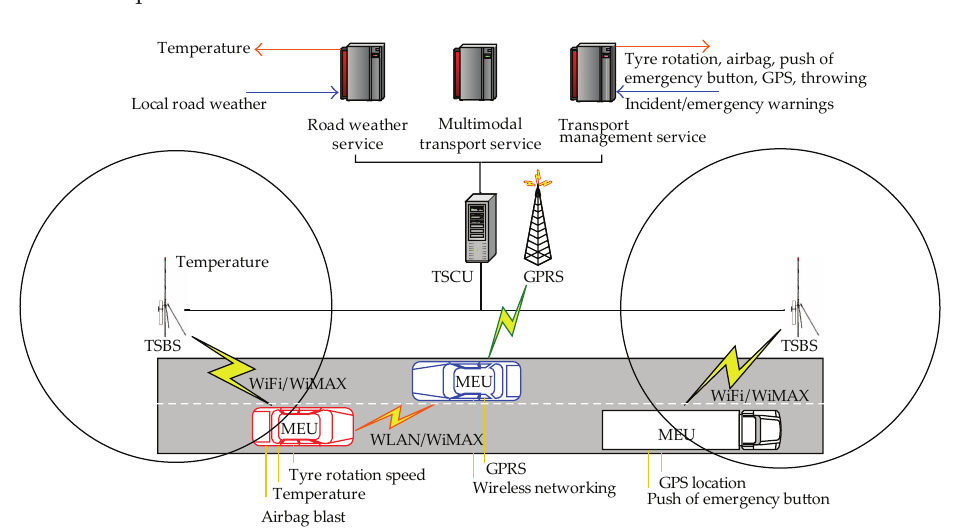
Figure 5: Carlink platform architecture.